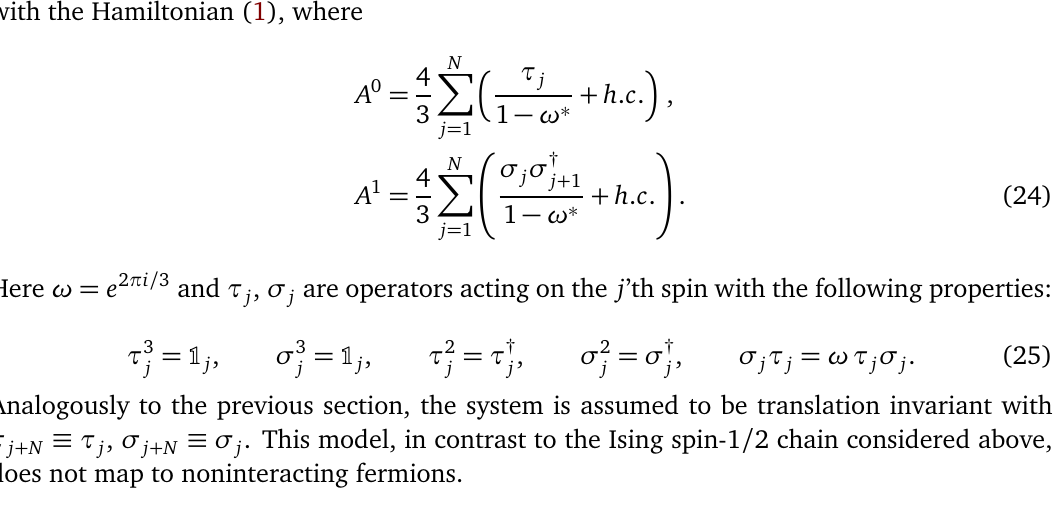
between two l = 1 max